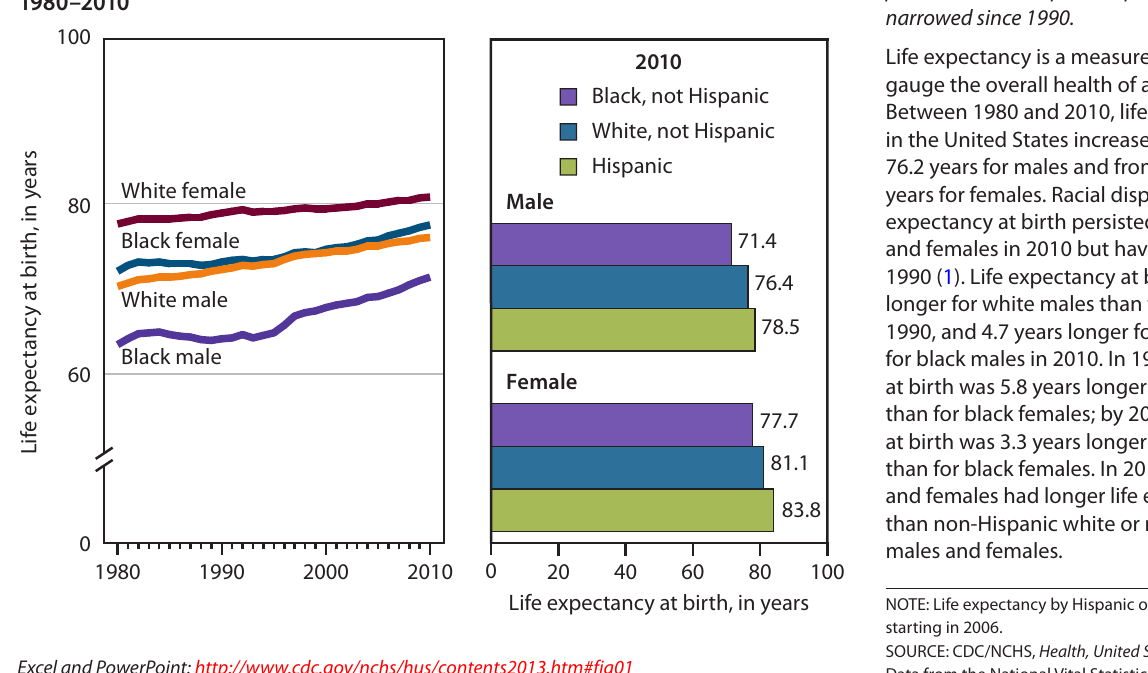
Figure 1. Life expectancy at birth, by selected characteristics: United States,